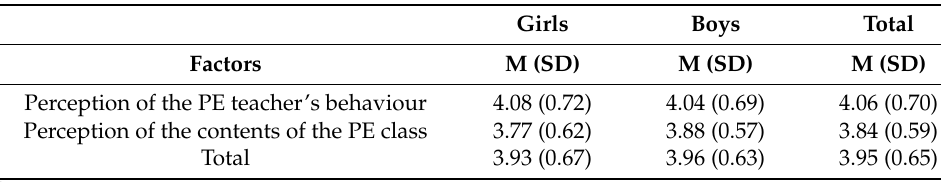
Table 3. Descriptive results of the CAPPEF factors, by sex.